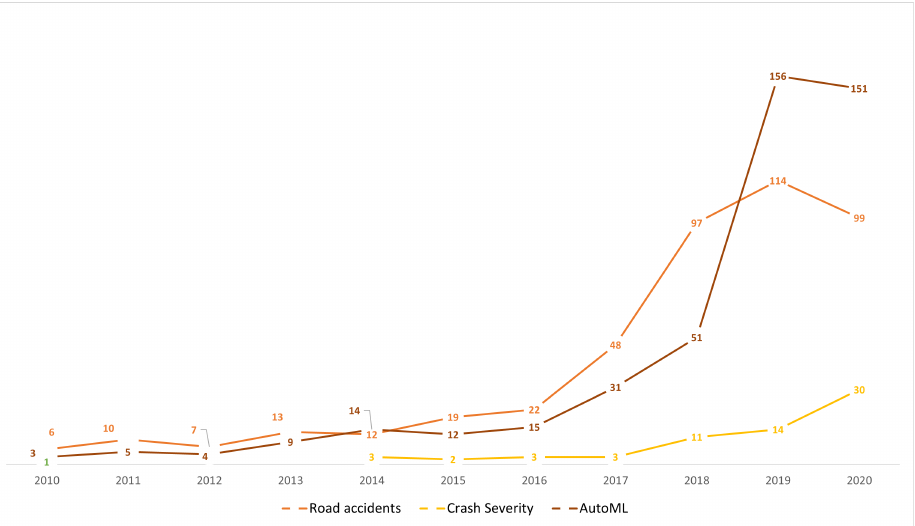
Figure 3. Year-wise distribution of research in the fields of Road Accident, Crash Severity, and